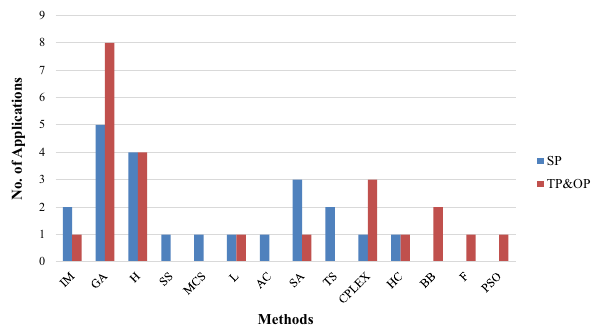
Fig. 5 A summary of methods used in urban transit planning. IM iterated local search, GA genetic algorithm, H heuristic, SS scatter search algorithm, MCS Monte-Carlo simulation, L Lagrangian decomposition/relaxation, AC ant colony optimization, SA simulated annealing, TS tabu search, HC hill climbing, BB branch-and-bound algorithm, F fuzzy mathematical programming, PSO particle